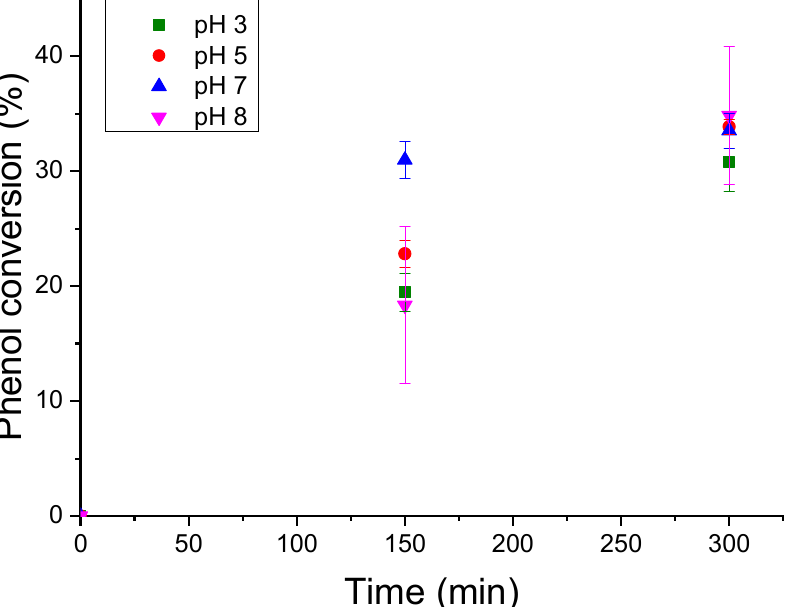
Figure 10. The effect of pH on the heterogeneous photodegradation of phenol, fixing T = 40 ◦ C, an Figure 10. The e ff ect of pH on the heterogeneous photodegradation of phenol, fi xing T = 40 °C, an initial phenol concentration of 25 ppm, and a catalyst loading of 0.125 initial phenol concentration of 25 ppm, and a catalyst loading of 0.125 g/L.